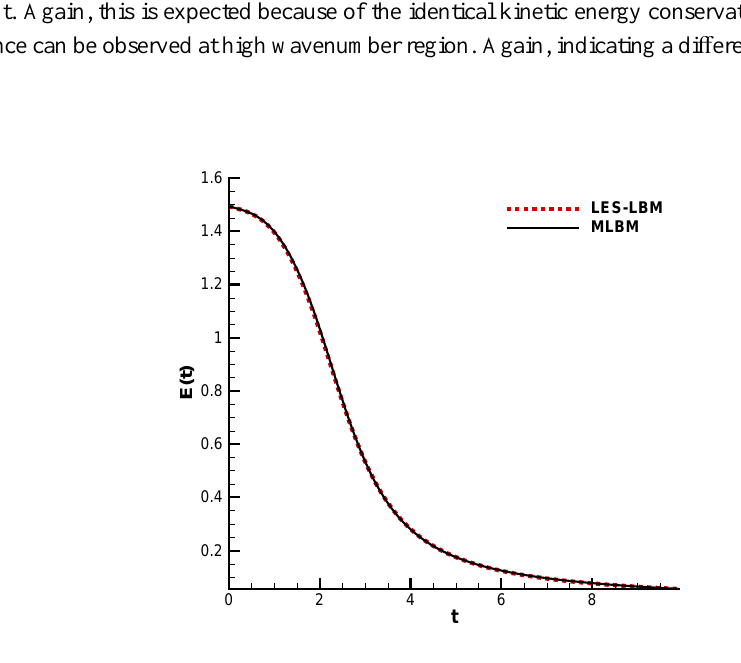
Fig. 2 Comparison of kinetic energy decay at resolved case of Re λ = 225 at mesh 256 3 .